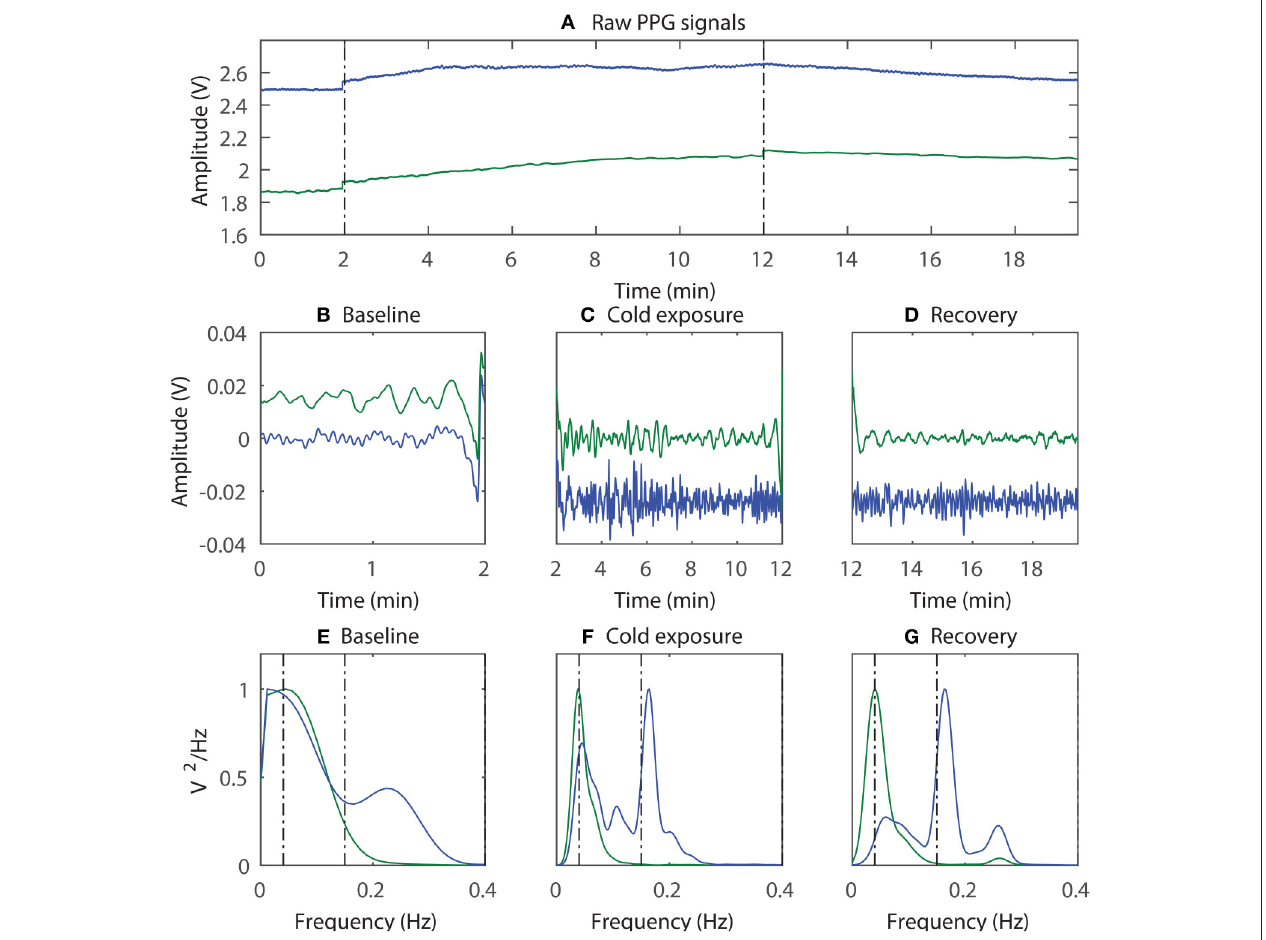
FIGURE 3 | An example of the sympathetic activity estimation; (A) The raw PPG signals acquired from the ear canal (blue trace) and the finger (green trace) were first bandpass filtered and then divided into three segments, each containing data from (B) baseline, (C) cold exposure, and (D) recovery; The power spectrum of the corresponding signals was then acquired (E–G)